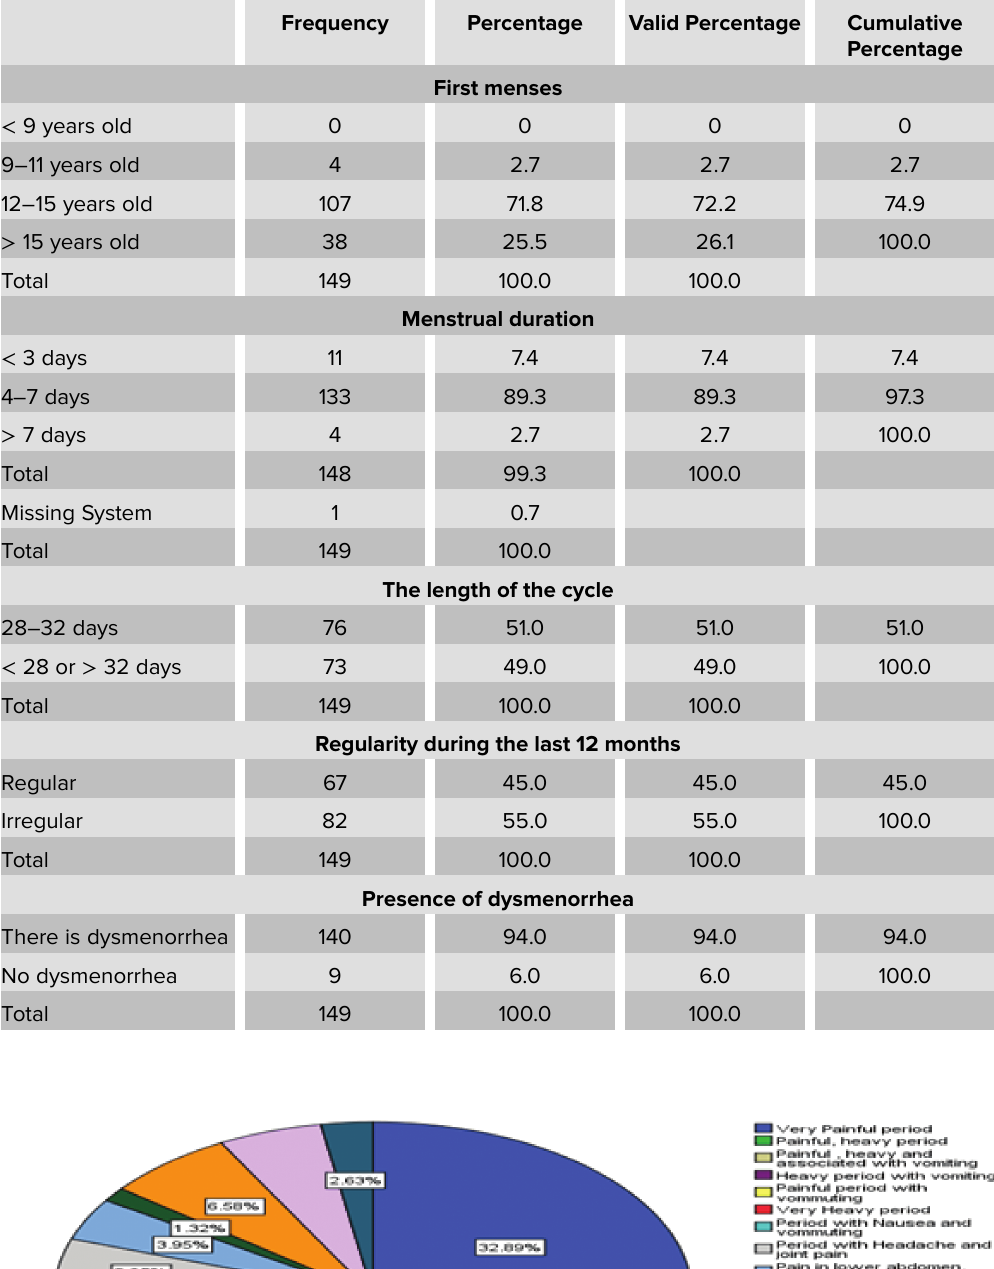
TABLE 2: Menstrual history ( n = 149)